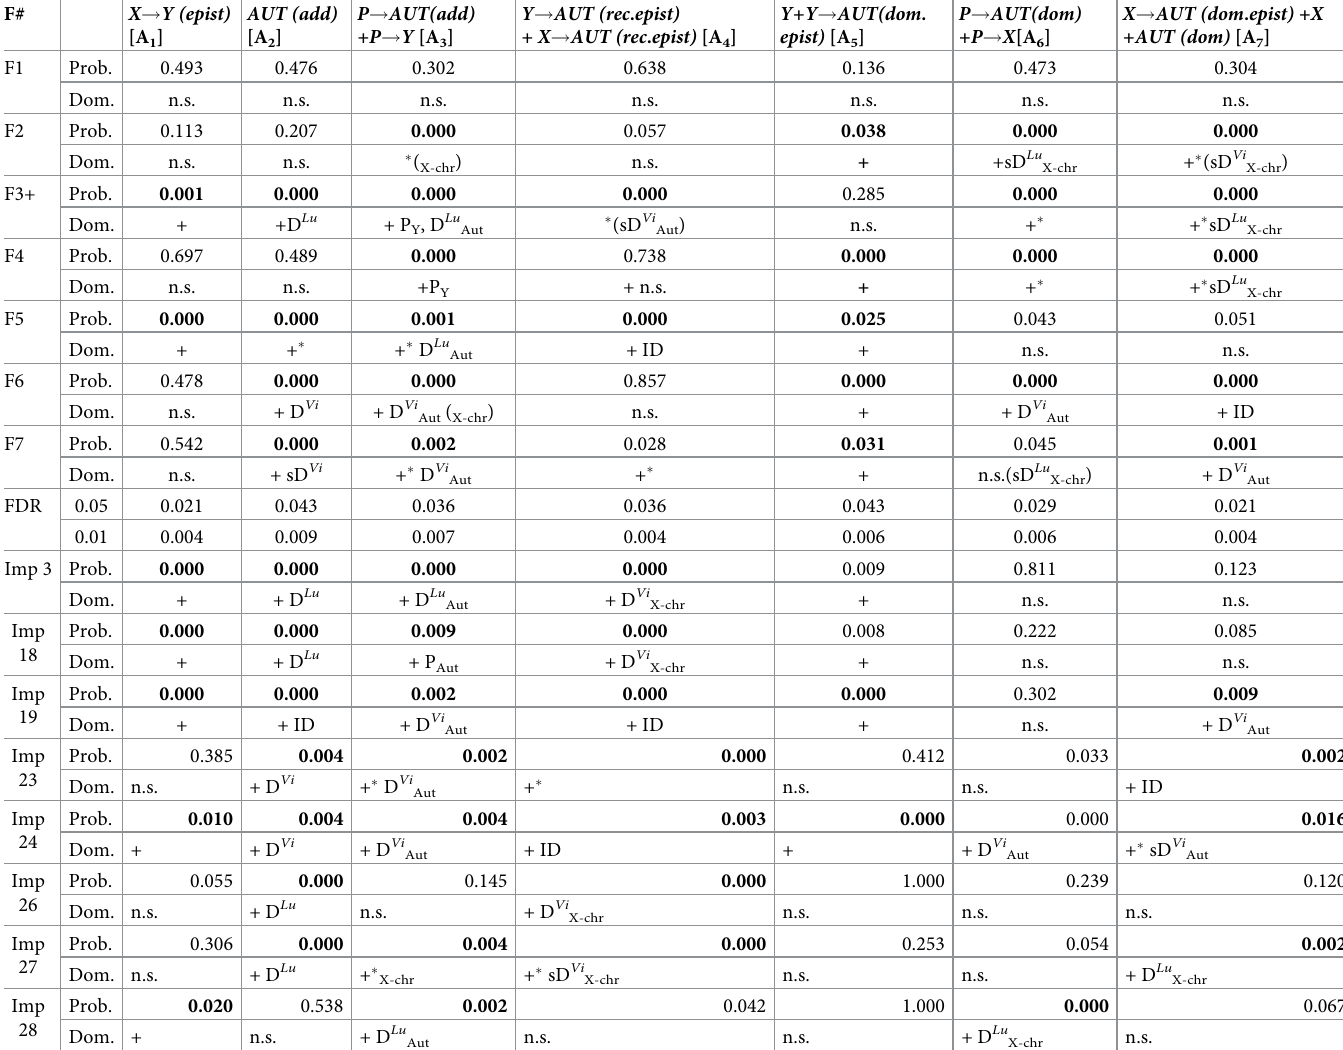
Table 6. Paired permutation test with the Bonferroni correction to evaluate the optimal genotype partitioning into groups homogeneous in latent variables and highly specific variables (up to 100 000 iterations in each